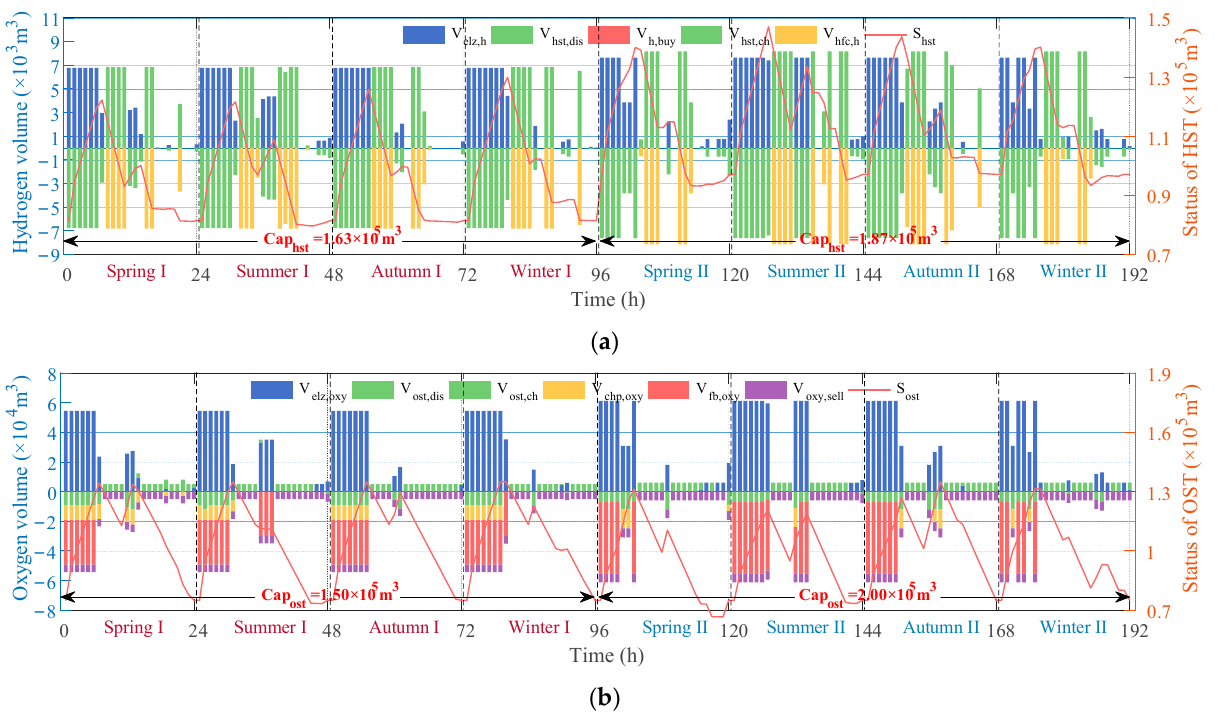
Figure 9. Relationship between Oxygen/hydrogen Input and Output in Two Stages of Case 1: ( a ) Hydrogen; ( b ) Oxygen.